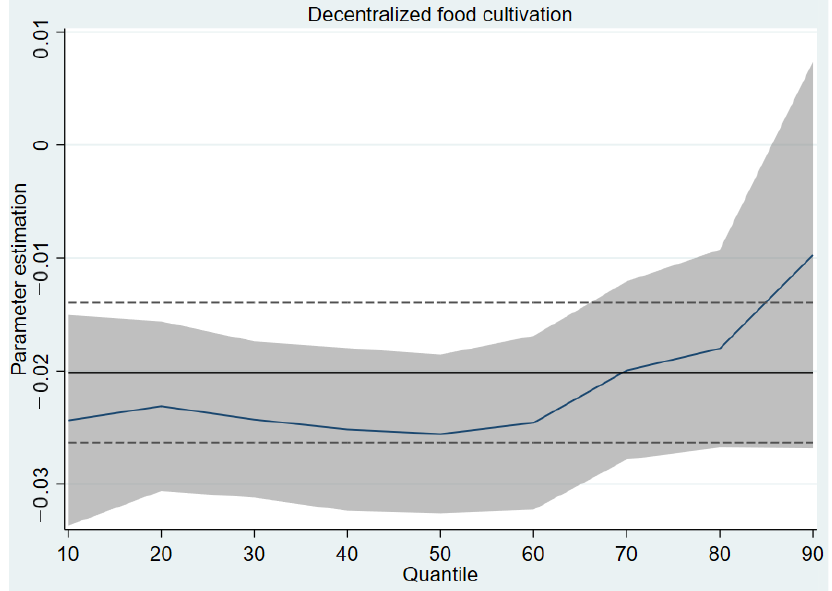
Figure 4. Quantile regression diagram of decentralized food crop cultivation. Note: The blue curve in this figure represents the coefficient of decentralized food crop cultivation at different loci obtained by quantile regression, and the gray area represents the 95% confidence interval of the coef- ficient.